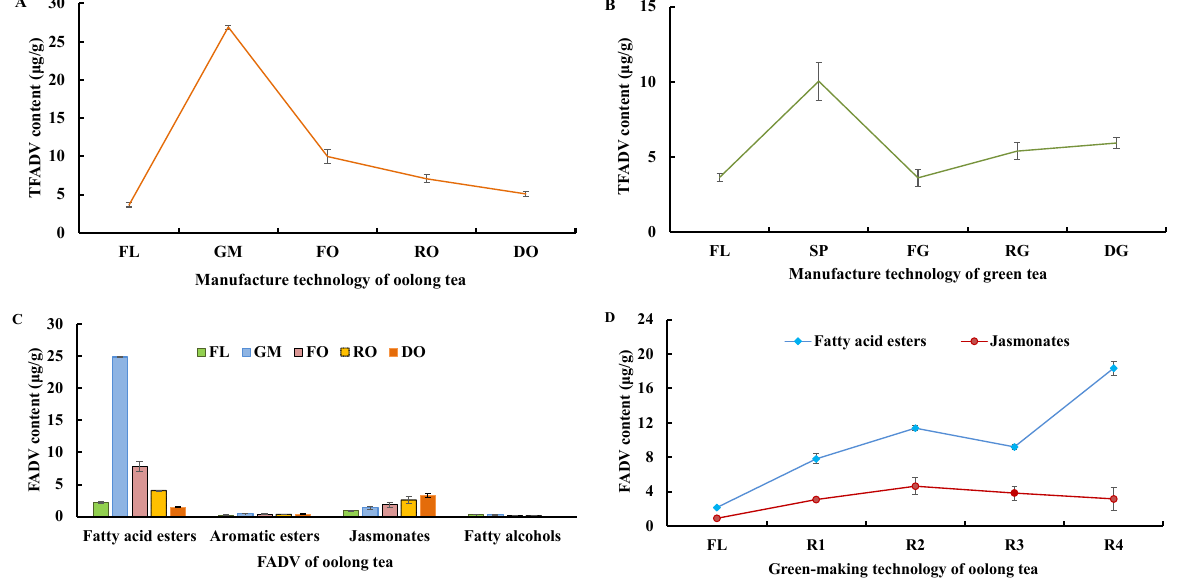
Figure 5. FADV influenced by tea processing technology. ( A ) Total FADV changed during oolong tea processing; ( B ) total FADV varied during green tea processing; ( C ) different FADV changed during oolong tea processing; and ( D ) the effect of green-making technology on fatty acid esters and jasmonates. TFADV indicates total fatty acid derivatives; FL, GM, FO, RO, and DO indicate fresh leaves, green-making step, fixation of oolong tea, rolling of oolong tea, and drying of oolong tea, respectively; FL, SP, FG, RG, and DG indicate fresh leaves, spreading, fixation of green tea, rolling of green tea, and drying of green tea, respectively; and FL, R1, R2, R3, and R4 indicate fresh leaves, 1st turnover, 2nd turnover, 3rd turnover, and 4th turnover of oolong tea, respectively. Different types of FADV showed different changes during oolong tea preparation (Figure 5C), and only fatty acid esters demonstrated the same trend as TFADV. The per- centage of fatty acid esters in TFADV ranged from 28.8 to 92.3% and reached a peak at the GM step. The content of fatty acid esters of the GM sample was 11.5-fold that of fresh leaves and then decreased to 1.48 μ g/g in oolong tea. The content of jasmonates was less than that of fatty acid esters in the fresh leaves, which increased gradually and reached 3.28 μ g/g in oolong tea. The contents of aromatic esters and fatty alcohols were relatively low and slightly changed, so we speculated that fatty acid esters and jasmonates probably played an important role in aroma quality formation. The content of fatty acid esters and jasmonates varied as the number of turnovers increased (Figure 5D). The order of fatty acid ester content was fresh leaves (FL) < R1 < R3 < R2 < R4, indicating that the 3rd turnover was the key point of fatty acid ester variation. The fatty acid ester content of the R3 sample was 19.3% and 50.0% lower than those of R2 and R4, respectively. Jasmonates exhibited a different order: FL < R1 < R4 < R3 < R2, that is, the jasmonates content was more influenced by the fourth turnover. The jasmonates content of R4 leaves was 31.9% and 17.9% lower than those of R2 and R3, respectively. Further analysis revealed that unlike the fourth turnover, the first three turnovers had a similar effect on fatty acid esters and jasmonates (FL < R1 < R3 < R2).